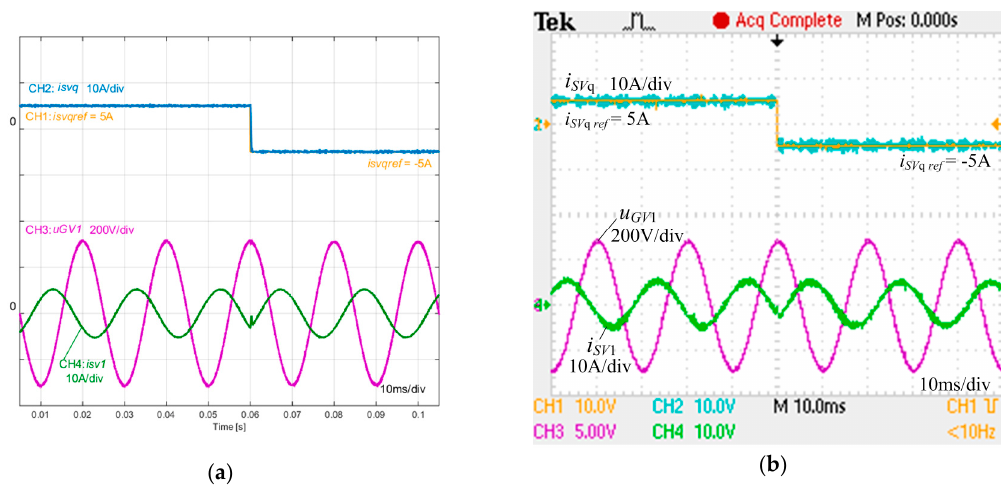
Figure 7. Phase current control: ( a ) Simulation result, CH1: i SVqref , 10 A/div; CH2: i SVq , 10 A/div; CH3: u GV 1 , 200 V/div; CH4: i SV 1 , 10 A/div; 10 ms/div; ( b ) Experimental result, CH1: i SVqref , 10 A/div; CH2: i SVq , 10 A/div; CH3: u GV 1 , 200 V/div; CH4: i SV 1 , 10 A/div; 10 ms/div.